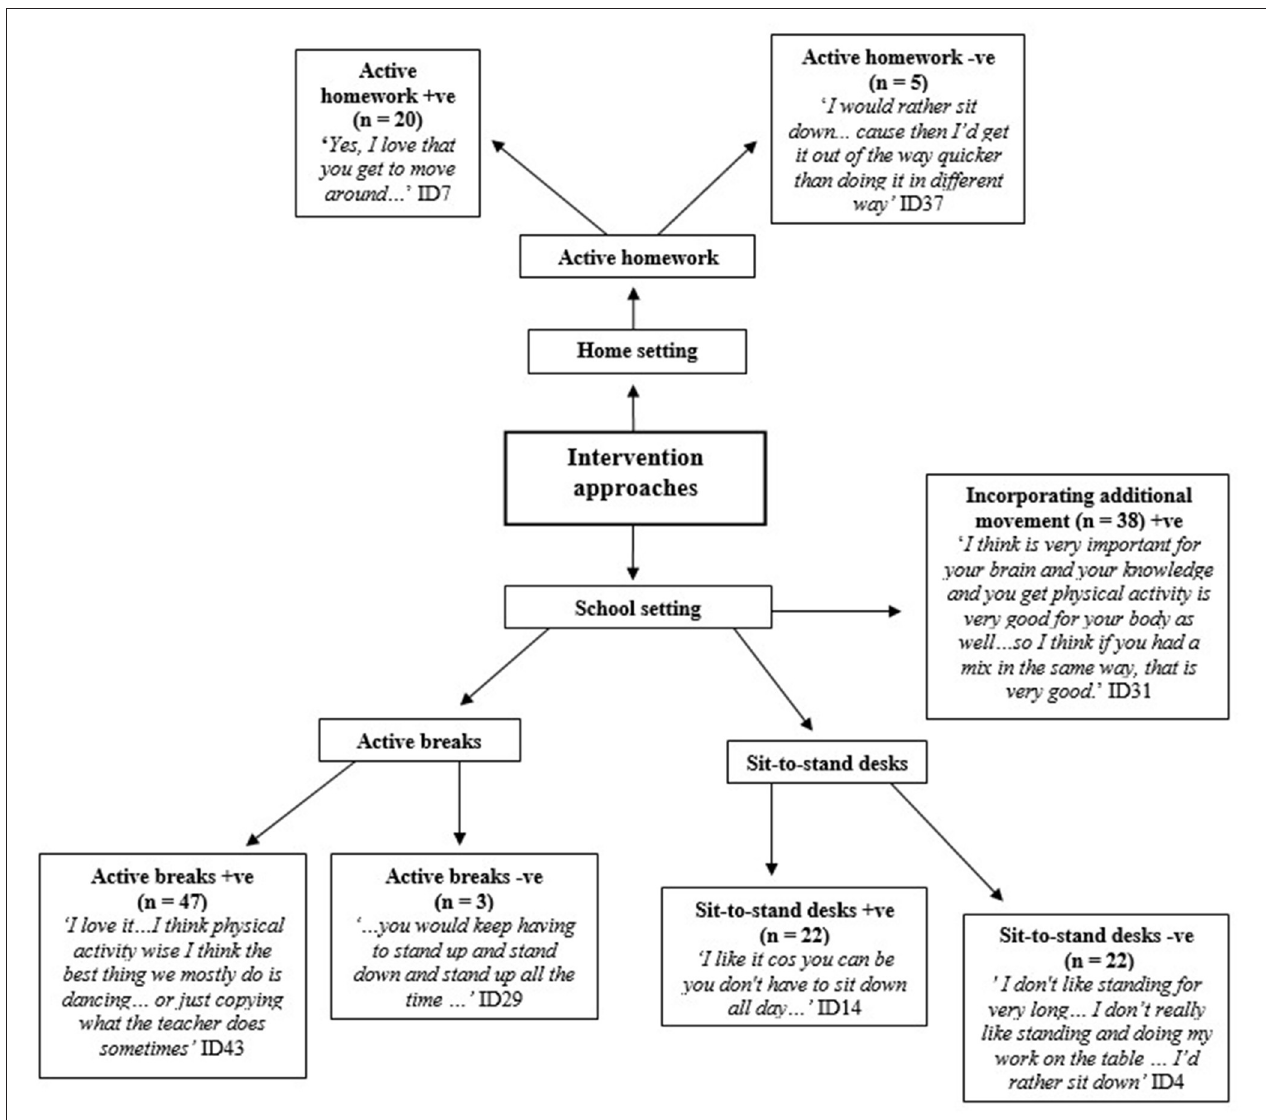
FIGURE 6 | Intervention approaches to tackle children’s physical inactivity + ve = positive -ve = negative.